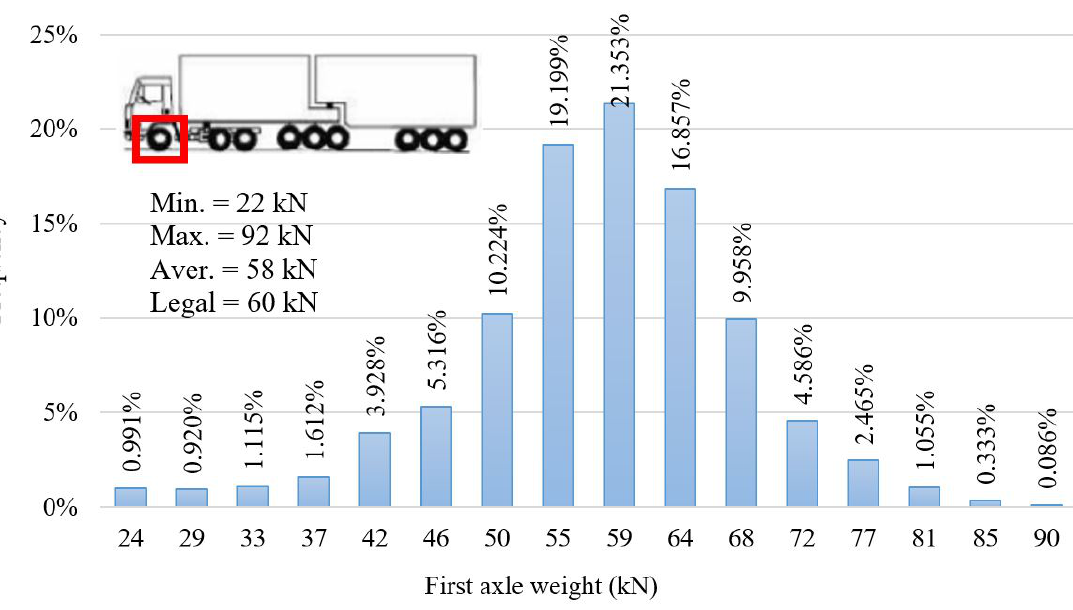
Figure 5. Histogram for weight for first axle for class 3M6 (the horizontal axis shows the average values for each